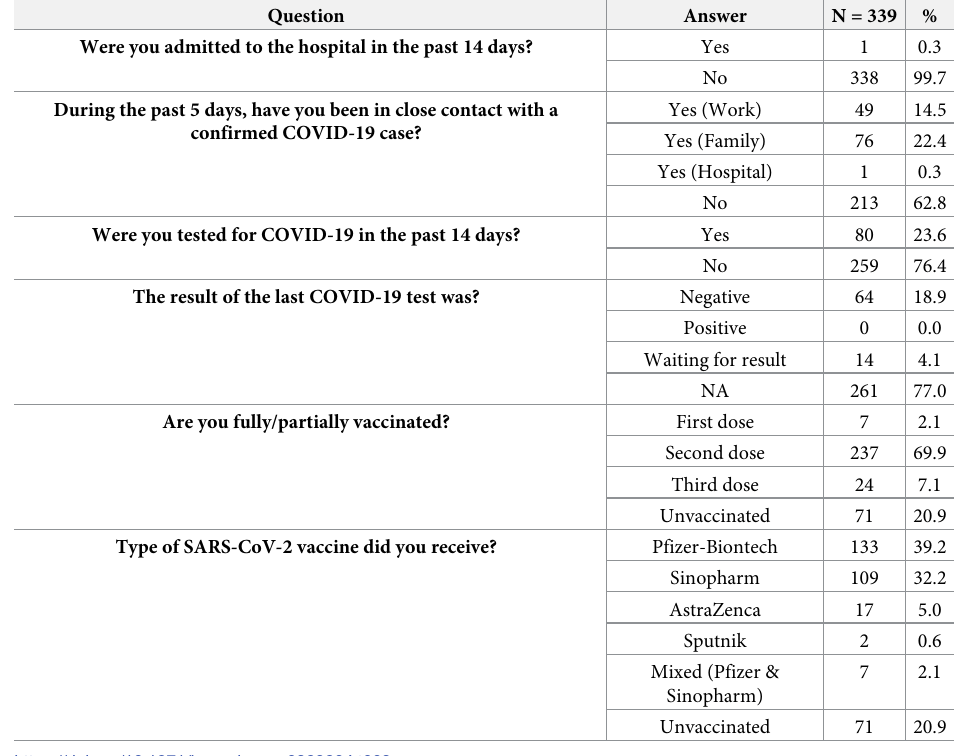
Table 2. Participants response regarding COVID-19 infection and SARS-COV-2 vaccination status. Question Answer N = 339 % Were you admitted to the hospital in the past 14 days? Yes During the past 5 days, have you been in close contact with a confirmed COVID-19 case?